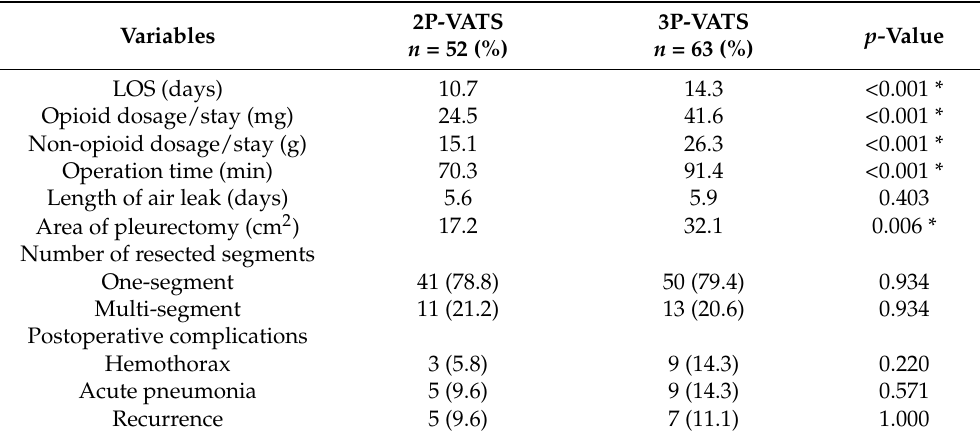
Table 2. Surgical and postoperative